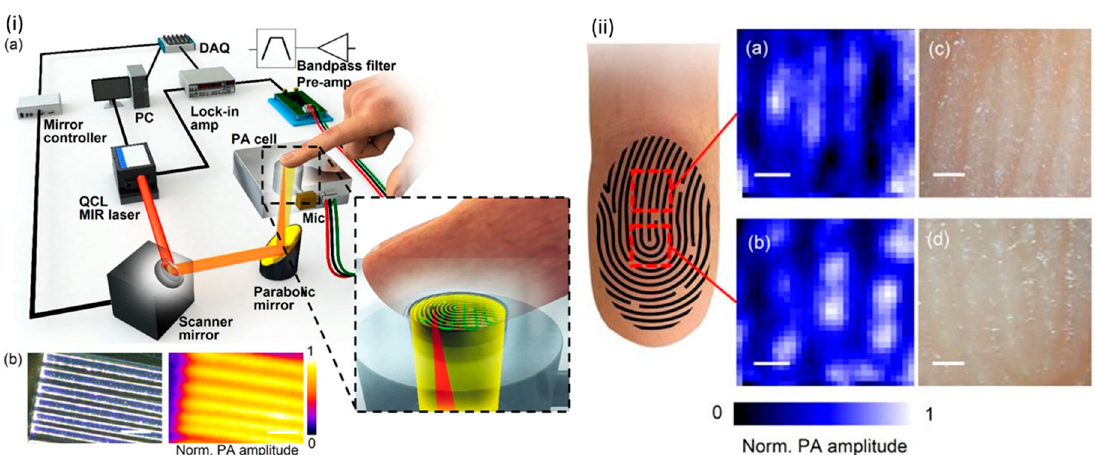
Figure 4. ( i )(a) A schematic of the position scanning photoacoustic (PA) microscopy system and (b) system resolution evaluation by SU-8 (a kind of photoresist structure). ( ii ) PA images (a)(b) and corresponding micrographs (c)(d) of two fingertip regions. Reprinted with permission from [100]. PC, personal computer; QCL, Quantum Cascade Laser; DAQ, data acquisition.